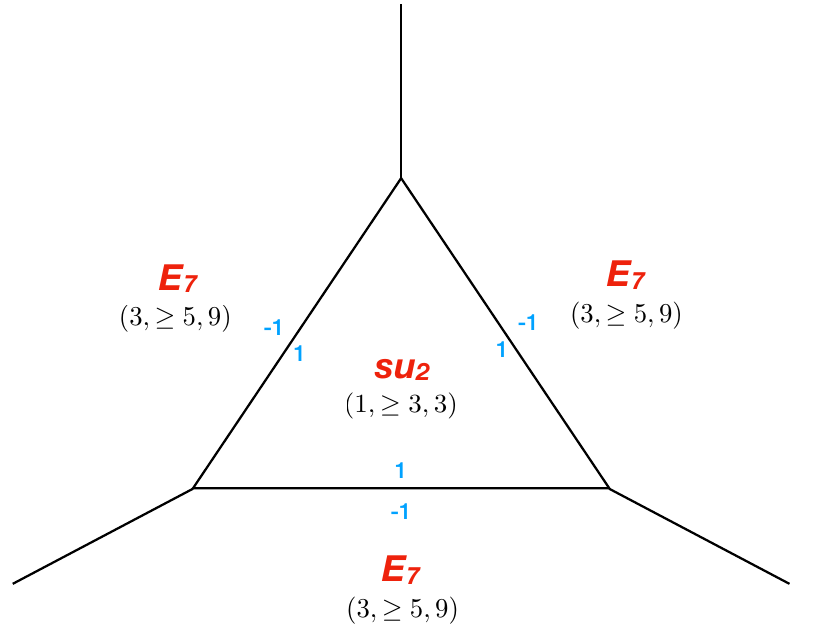
Figure 4 . The initially blown up E 7 { E 7 { E 7 Yukawa